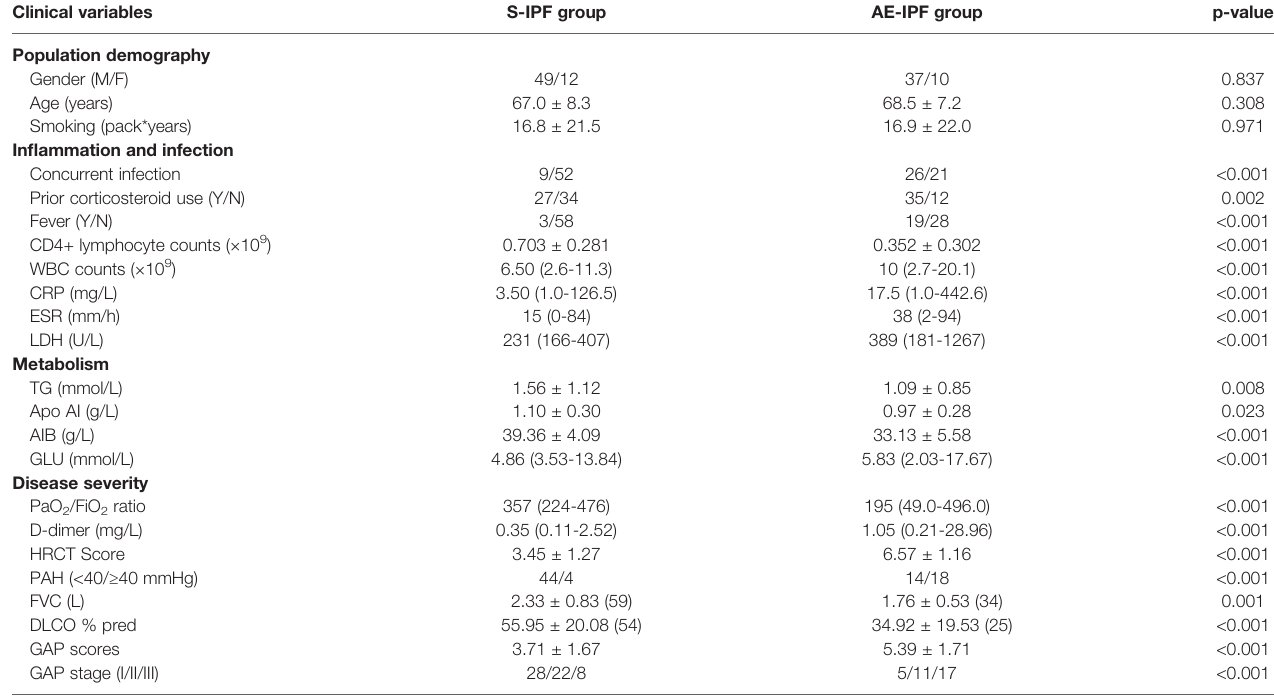
TABLE 1 | Comparison of clinical features between S-IPF and AE-IPF patients. Clinical